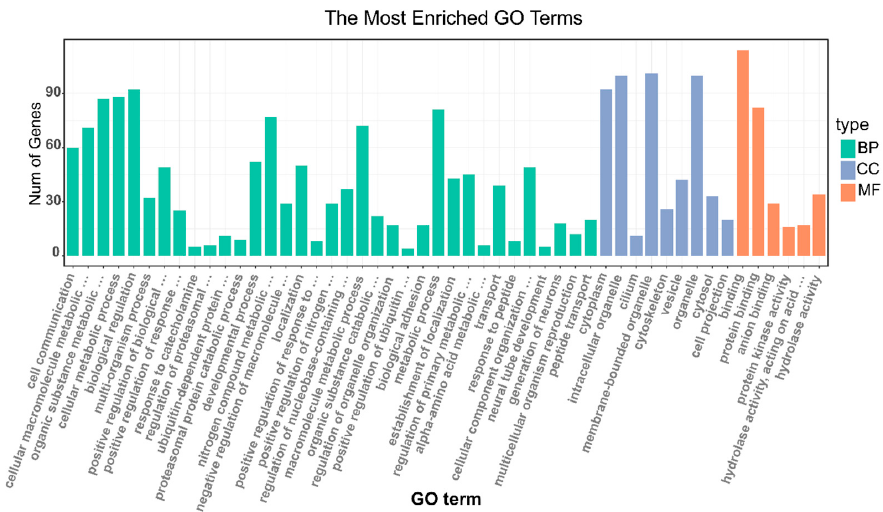
Figure 5. The gene ontology (GO) enrichment analysis of genes under positive selection.